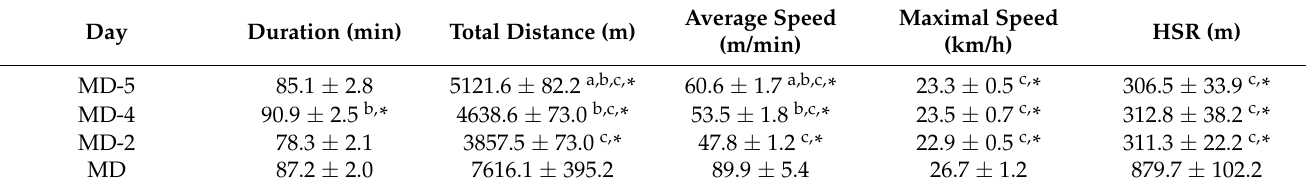
Table 1. External Intensity by running-based variables during training and matches for squad average (mean ±